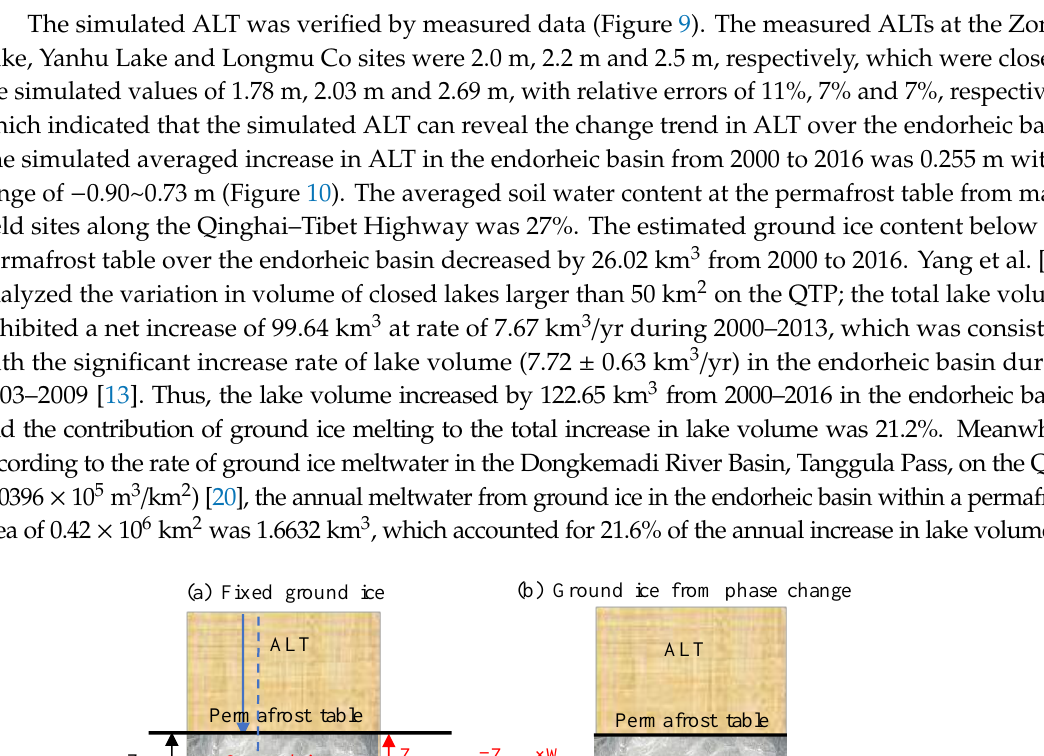
Figure 10. The spatial patterns of lake expansion and distribution of change in ALT during 2000–2016 over the endorheic basin. The positive numbers show an increase in the ALT and the negative numbers a decrease in the ALT; the black line contour is the QTP endorheic basin. In addition, a certain amount of unfrozen water was widely distributed in the permafrost, and the increase in unfrozen water content associated with the rising ground temperature of the permafrost will provide free water during the thawing–freezing process (Figure 9a). A simple power law was usually used to relate ground temperature T (°C) and gravimetric unfrozen water content Wu (Wu = a|T| −b , where a and b were empirical constants, which was soil parameters for different soil types) [45]. The unfrozen water content increased exponentially with permafrost ground temperature, and it reached the maximum when the ground temperature approached 0 °C (freezing point). During 2004–2017, the average annual ground temperature at 15 m depth from the QTB01, QTB06, QTB15 and QTB18 observation sites showed a rapid rising trend, varying from −0.87 °C in 2004 to −0.47 °C in 2017 at rate of 0.025 °C/yr. Accordingly, the unfrozen water content increased with the rising permafrost ground temperature for the same period, ranging from 0.78% to 1.13% at a rate of 0.0216%/yr (Figure 11). The increase in unfrozen water content implied that the decrease in ground ice content, which participated in phase change in permafrost during the freezing–thawing process of the active layer. The estimated annual ground ice content decreased by 1.32 km 3 , which contributed 17.2% for the annual increase in lake volume. Overall, the ground ice melting due to permafrost degradation has a total contribution of 38.4% for the lake volume increase. Compared